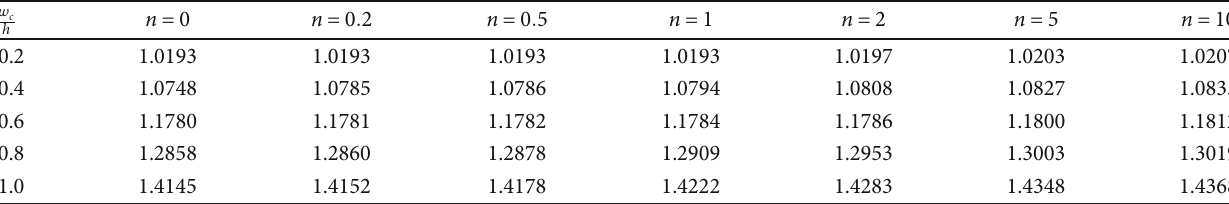
ω NL / L of 2D-FGM square plate,